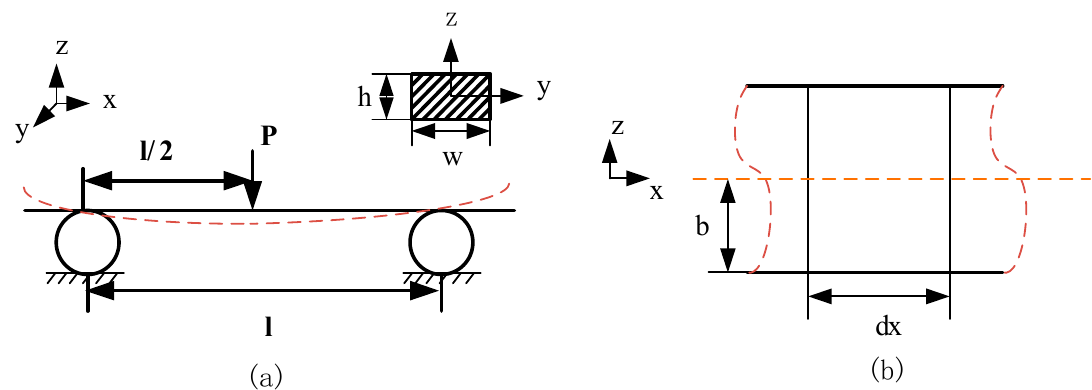
Figure 1. ( a ) Related parameters of the applied load (a load is applied to the middle of the sample, and the red dotted line indicates the sample with both ends warped after bending. ℎ , 𝜔 , respectively, represent the thickness and width of the sample); ( b ) sample microsegment ( 𝑏 is the distance of the carbon fiber layer from the neutral layer, 𝑑𝑥 is a microsegment of the beam).